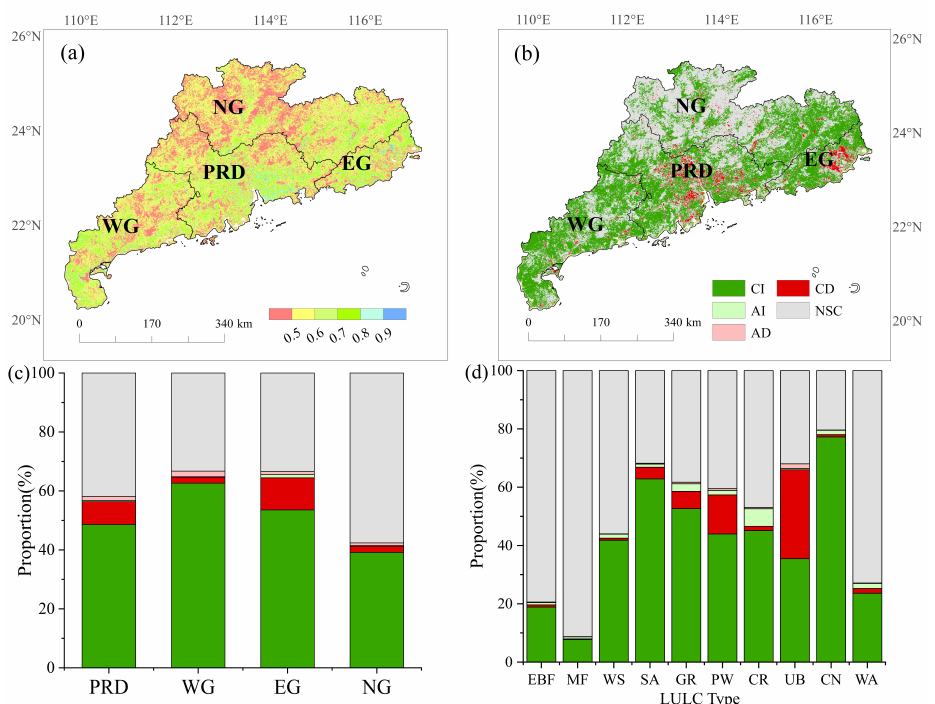
Figure 3. Consistency of vegetation greenness in southern China. ( a ) The spatial distribution of the 2000–2020 NDVI monthly maximum Hurst exponent in southern China. ( b ) the spatial distribution of the NDVI change trend in Guangdong Province. CI, CD, AI, AD, and NSC denote continuous improvement, continuous deterioration, anti-continuous improvement, anti-continuous deterioration, and nonsignificant change, respectively. ( c ) The proportion of each greenness trend and consistency categories in each LULC types. ( d ) The categorized box graph of the 2000–2020 NDVI monthly maximum Hurst exponent in southern China by types of region and change